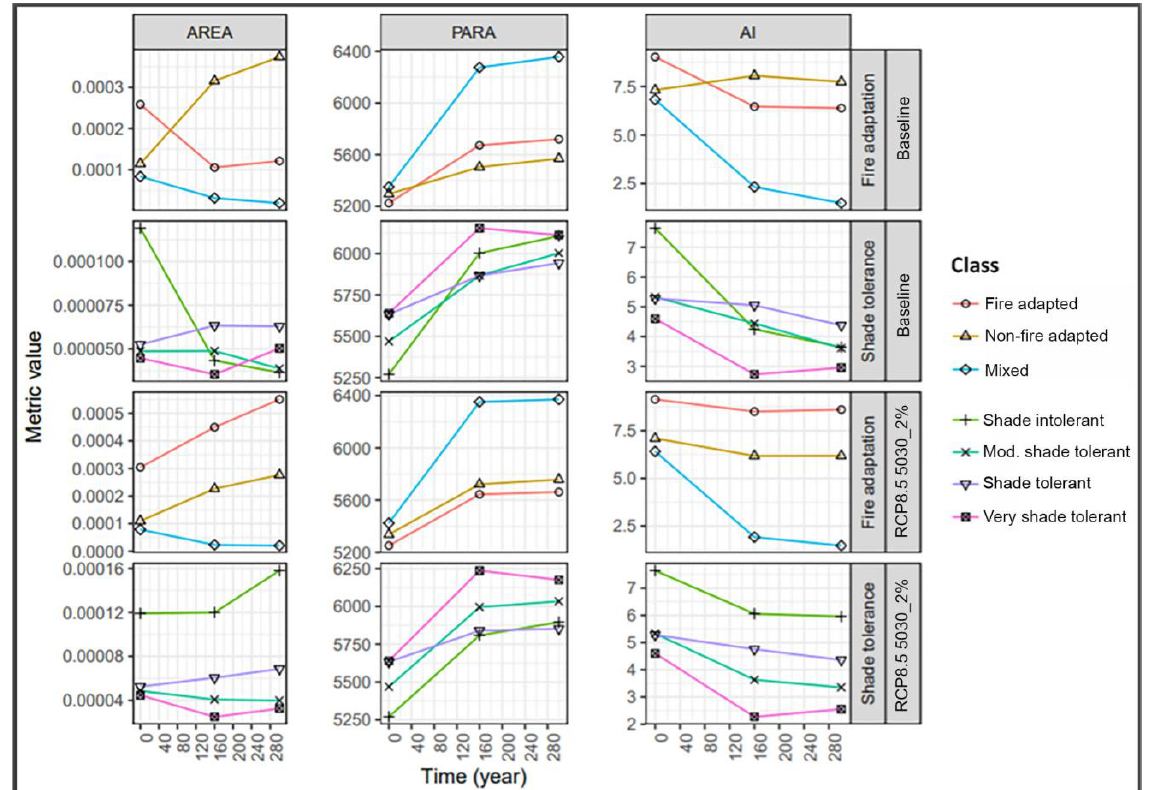
Figure 4. Landscape metrics from Figure 3 for the functional species groups of trees in the Boreal Forest of Quebec. (1) Fire adaptation and (2) shade tolerance under the baseline modeling scenario and the most severe climate change and forest management scenario RCP 8.5 5030_2%. Landscape metrics: AREA (mean patch area), PARA (measure of shape complexity), and AI (patch aggregation measurement).